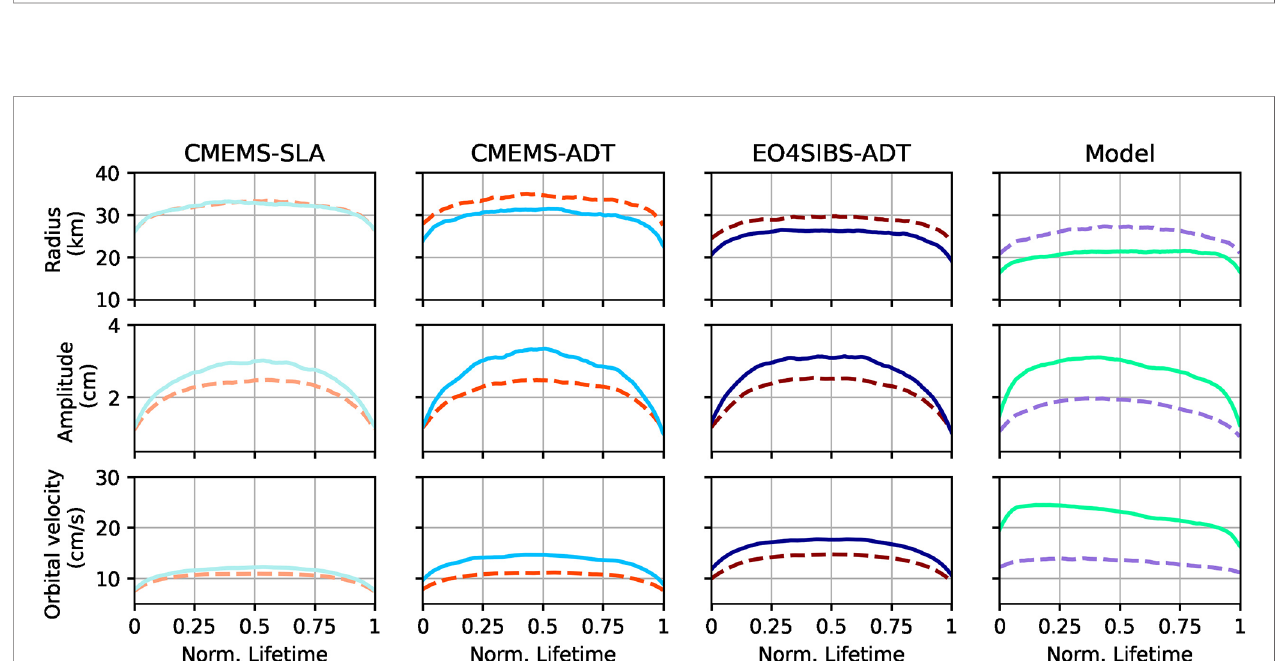
FIGURE 4 | Distribution of eddy properties as obtained from the different data sets for cyclones (A – C) and anticyclones (D – F) : effective radius (A, D) , orbital velocity (B, E) and amplitude (C, F)